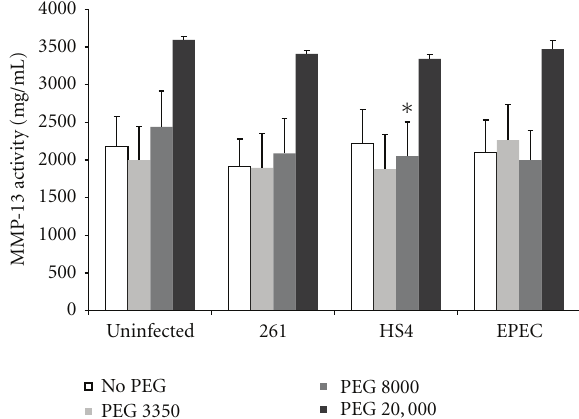
Figure 7: MMP-13 activity for Caco-2 cells infected with com- mensal and pathogenic bacteria and treated with 10% PEG. There was no change in MMP-13 activity in samples treated with either PEG 3350 or PEG 8000 as compared to control regardless of infection status. Infection with commensal bacteria or EPEC slightly decreased the MMP-13 activity. This was not statistically significant. Standard Student’s t -test was applied to the samples and the P < 0 . 05 were obtained for samples treated with PEG 8000 and HS4 indicated by an asterisk ( ∗